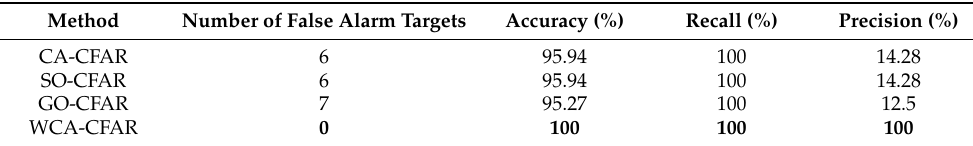
Figure 5. Comparison results of different one-dimensional CFAR detection algorithms: ( A ) 1D-CA- CFAR method; ( B ) 1D-SO-CFAR method; ( C ) 1D-GO-CFAR method; ( D ) 1D-WCA-CFAR method. Table 2. Comparison of simulation test